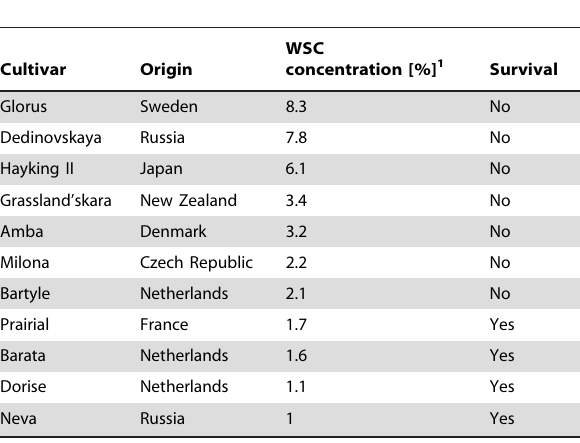
Table 2. Origin, concentration of water soluble carbohydrates (WSCs), and survival of Sitobion avenae clones on Cocksfoot